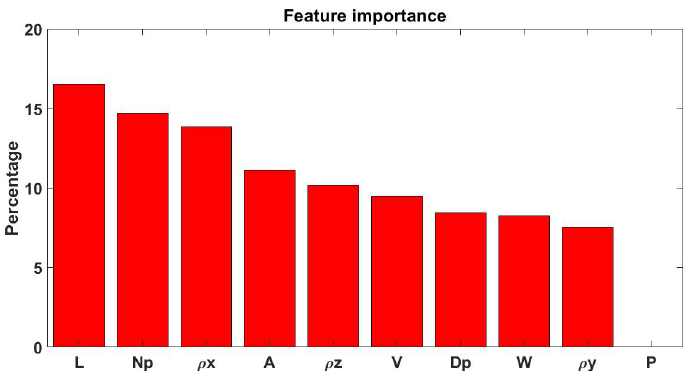
Figure 2. Bar plot representing feature importance. Abbreviations. A: area. D p : mean peaks distance from the bisecting line. L: length. N p : peaks number. P: percentage of the length which corresponds to the maximum plot wideness. ( ρ x, ρ y , ρ z ): length of the three radii of inertia of the semi-ellipsoidal three-dimensional cloud of points; V: volume. W: plot wideness.